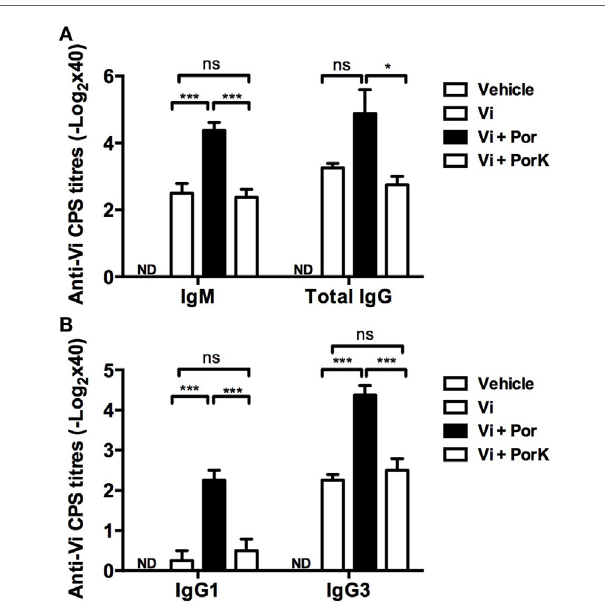
FigUre 4 | S. Typhi porins promote antibody responses to the T-independent anti-typhoid Vi antigen . Four BALB/c mice per group were immunized i.p. with 10 μ g of Vi CPS vaccine (Typhim), Vi + 10 μ g porins or Vi + 10 μ g of PorK on days 0 and 15. (a) IgM and total IgG responses and (B) IgG1 and IgG3 responses against Vi CPS were measured by ELISA on day 20 post-immunization. Mean + SEM are plotted. These data are representative of two independent experiments. Statistical analysis was performed using one-way ANOVA with Bonferroni test post hoc . Statistical differences are depicted as * P < 0.05, ** P < 0.01, *** P <